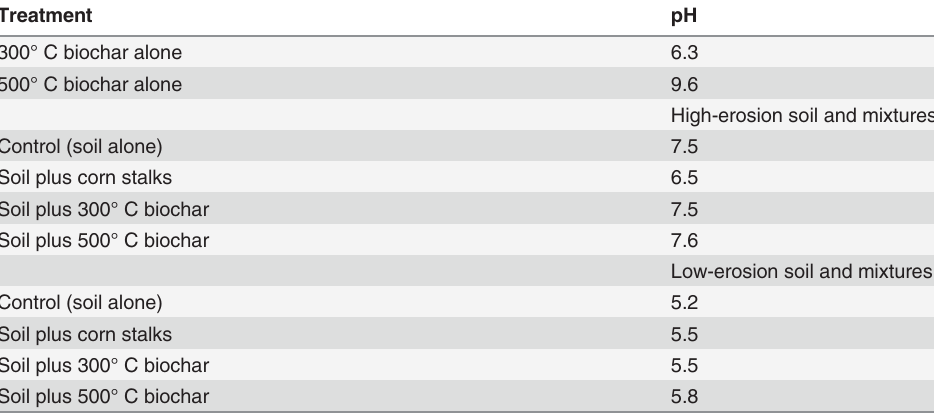
Table 2. pH of the soils and soil-biochar